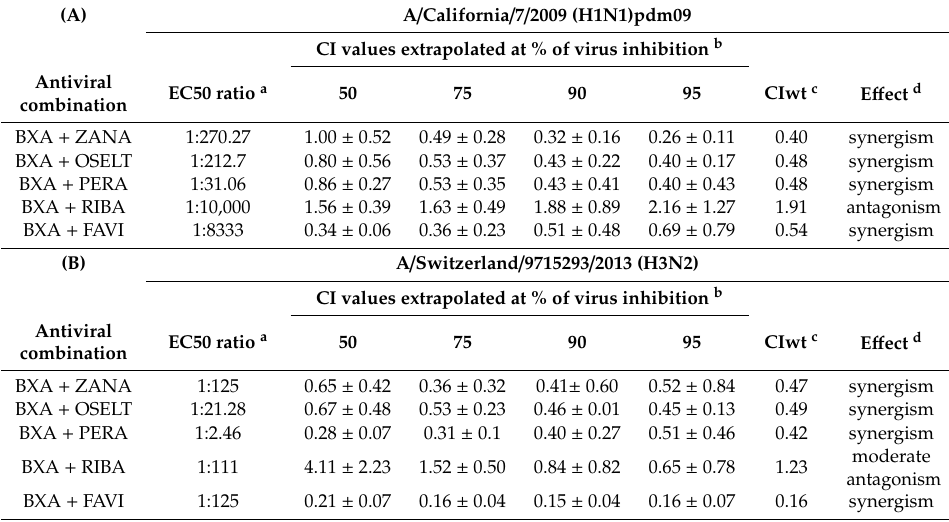
a Ratio of EC50 values (e ff ective concentrations that inhibit cytopathic e ff ects of each virus by 50%) of each drug alone (that is EC50